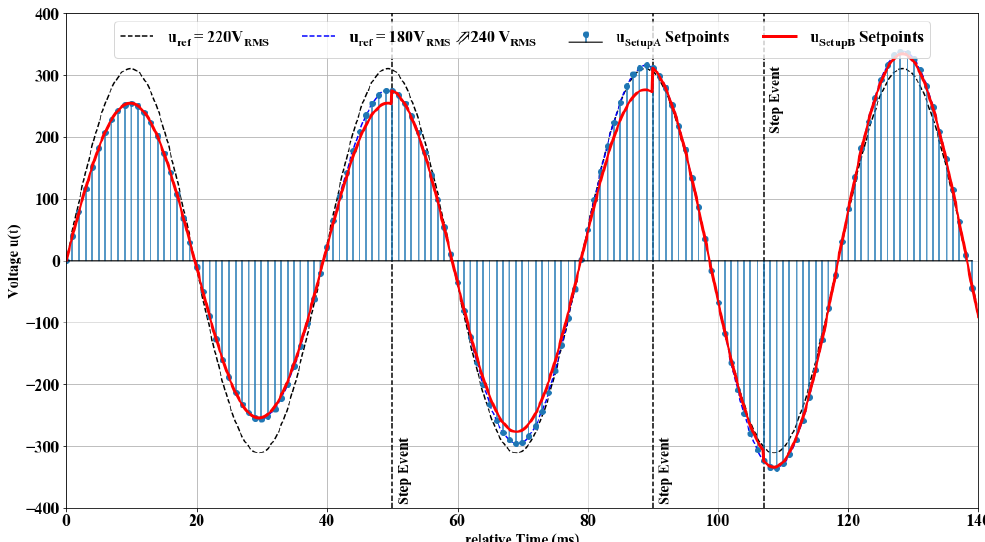
Figure 5. Visualisation of voltage rise event from 180 V RMS to 240 V RMS in a time frame of 140 ms. The update principles for the different power interface and the corresponding simulation step resolution are illustrated. For System Setup A, an update rate of 1 ms of the u ( dt ) is illustrated. In comparison to System Setup B, discrete update steps are illustrated. The used resolution does not correspond to the actual used setups and is for illustration purpose